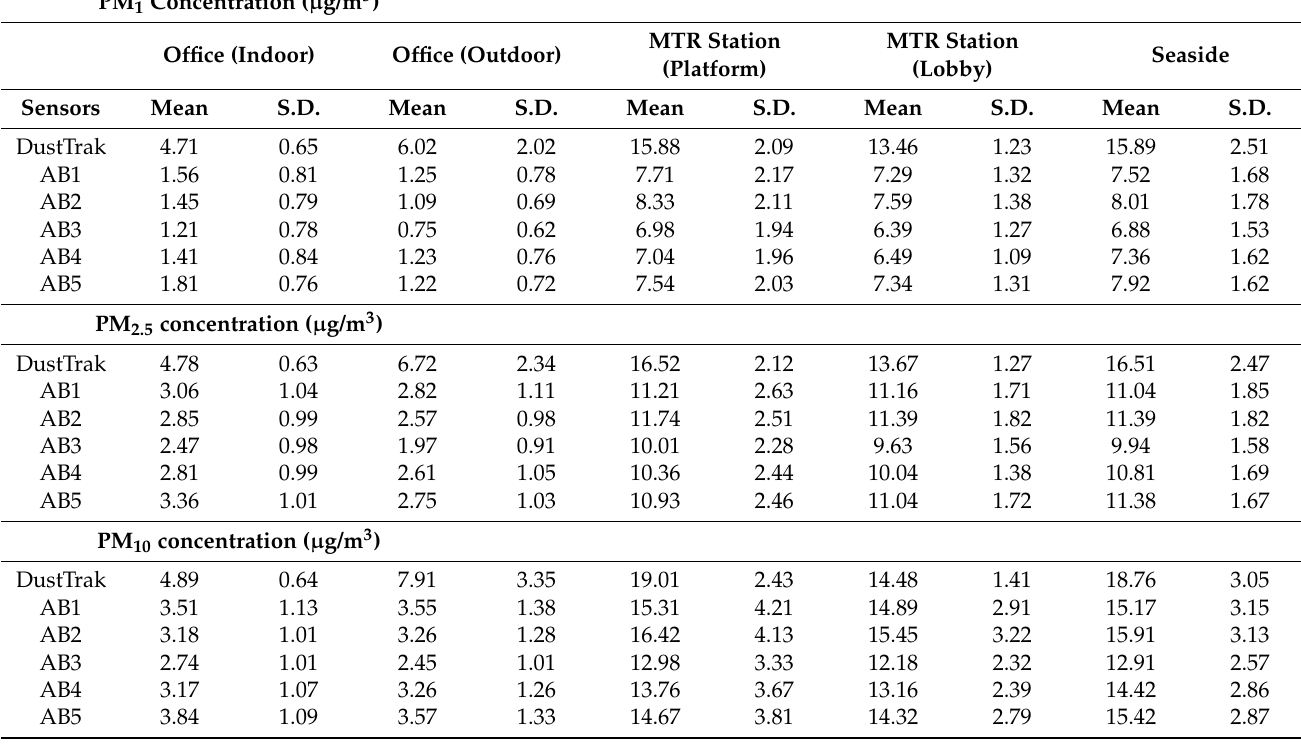
Table 2. Statistic description of the 1 min PM 1 , PM 2.5 , and PM 10 average concentrations ( µ g/m 3 ) reported by AirBeam2 and DustTrak sensors in different